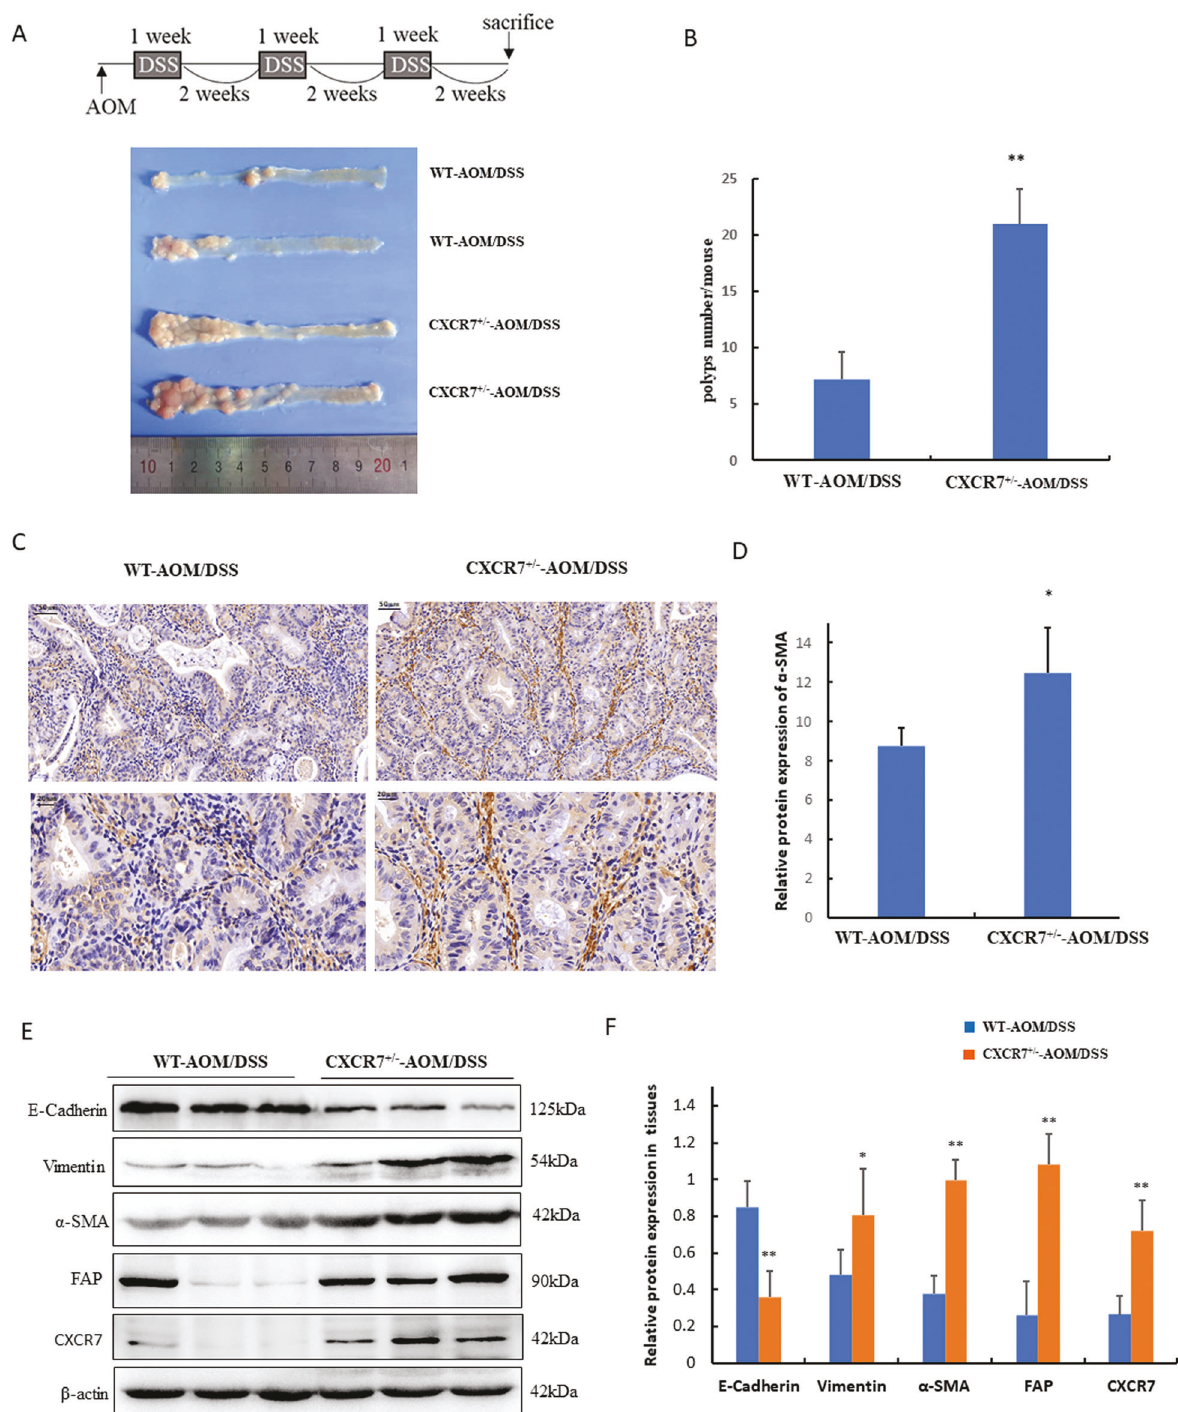
Fig. 2 CXCR7 promotes CAF activation in transgenic mice. A The schematic regimen of colitis-associated cancer model by treatment with three cycles of AOM/DSS. Representative images of colons from AOM/DSS-treated WT ( n = 8) and Villin-CXCR7 ( CXCR7 + / − ) transgenic mice ( n = 8). B Total polyp counts per mouse were examined in different groups ( n = 8). ** p < 0.01 vs. WT mice. C , D IHC analysis of the expression of α -SMA in colonic tissues of AOM/DSS-induced WT and Villin-CXCR7 ( CXCR7 + / − ) transgenic mice and statistical analysis was performed. * p < 0.05 vs. WT mice ( n = 6), scale bar = 50, 20 μ m. E , F Western blot analysis of the expression of E-cadherin, Vimentin, α -SMA, FAP, and CXCR7 in colonic tissues of AOM/DSS-induced WT and Villin-CXCR7 ( CXCR7 + / − ) transgenic mice normalized to β -actin and statistical analyses were performed. * p < 0.05, ** p < 0.01 vs. WT mice.